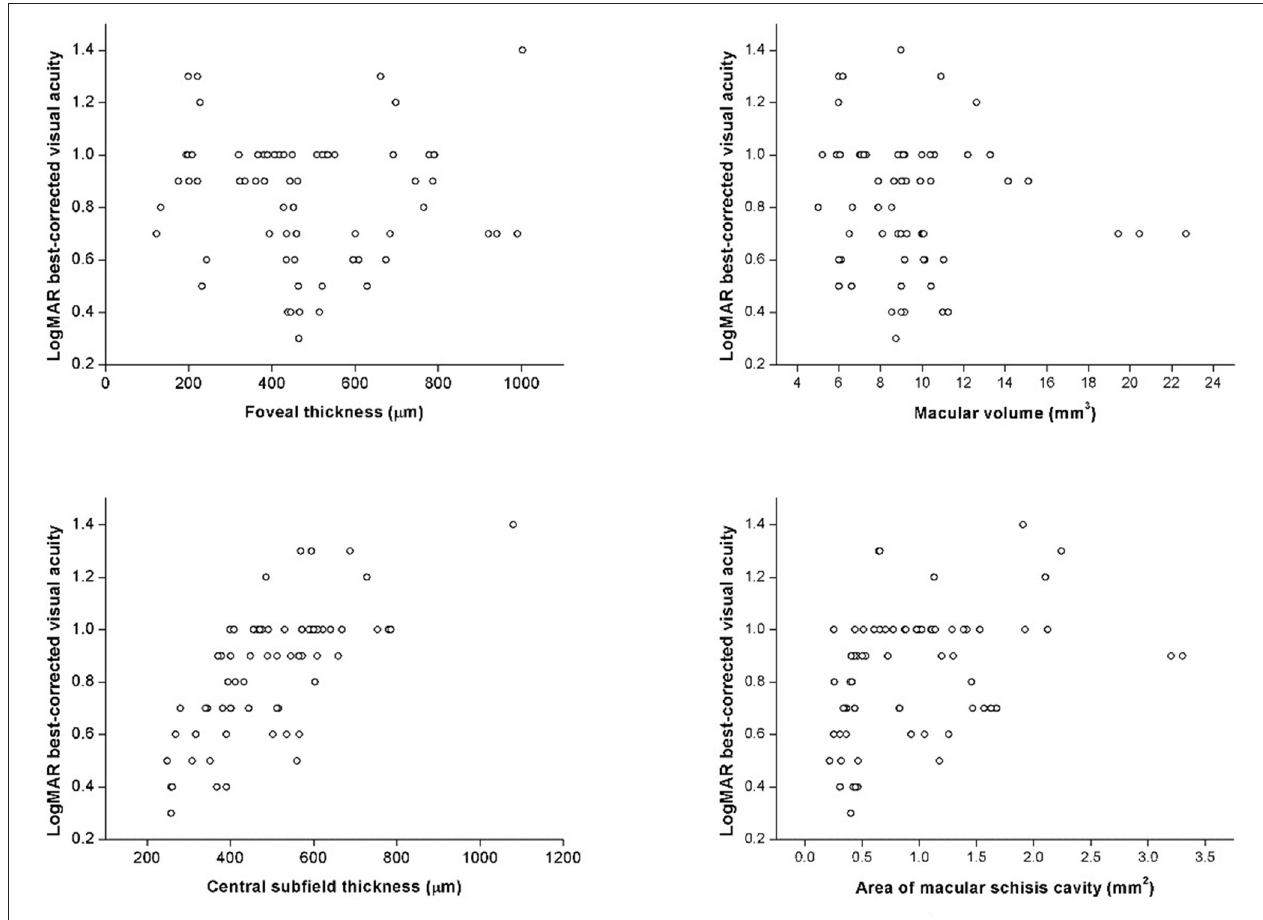
FIGURE 5 | The scatter plots represent the linear correlations between BCVA and structural properties determined by spectral-domain optical coherence tomography.